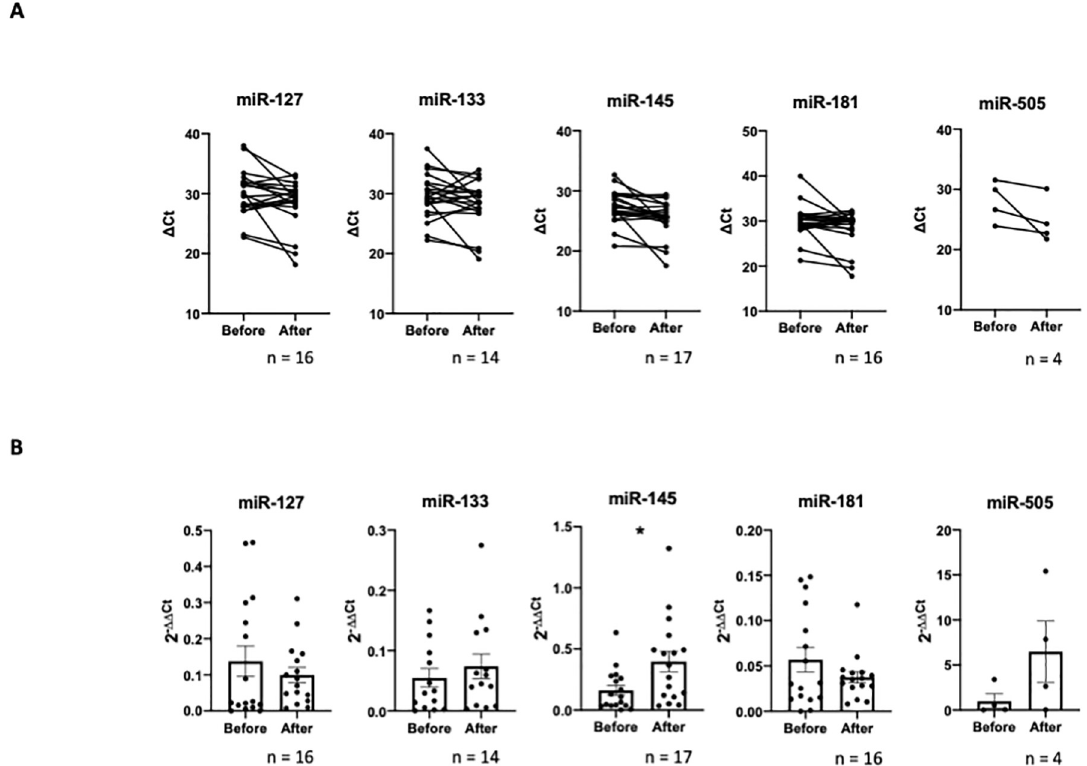
Fig 3. QPCR validation of identified miRNA targets. A Individual miRNA changes displayed as CT-Values before and after the polygraphically monitored night. B Relative miRNA expression . Different patient numbers due to outlier deletion, undetectable targets or low RNA input amount. All values displayed ± SEM, Outlier test Prism8; Mann-Whitney significance test, � P < 0 . 05 .